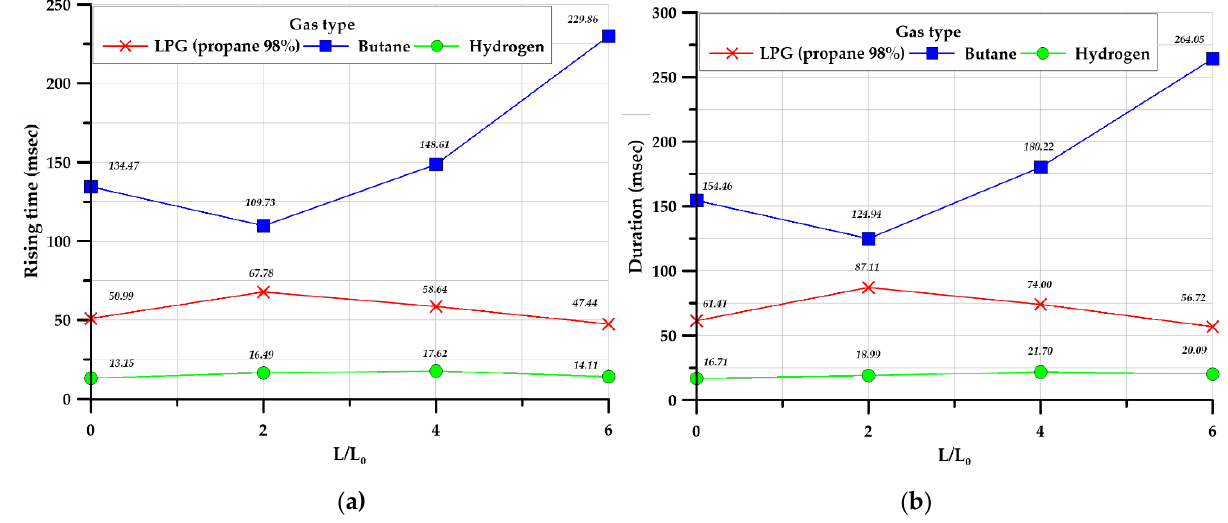
Figure 14. Average of rising time ( a ) and duration ( b ) in the cylinder-type